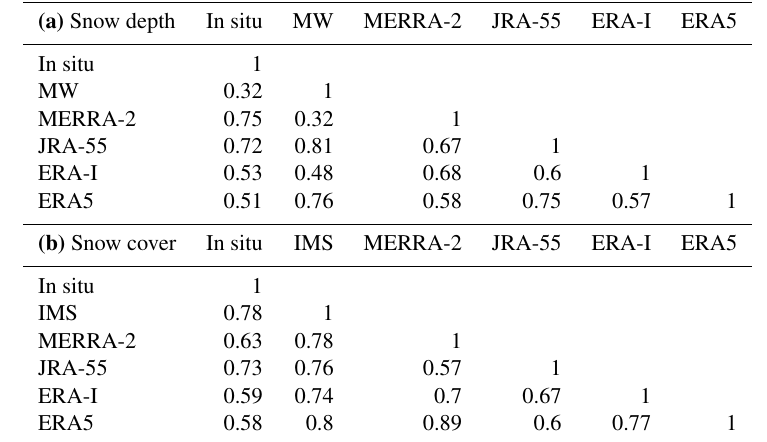
Table 2. Temporal correlation matrix between in situ observations and reanalyses or satellite data for daily SD (a) and daily SCF (b) . The IMS low estimate has been used. Correlations are calculated over the whole 5-year period, except for MW SD data for which the years 2009 and 2010 are used and are averaged over the 33 stations.